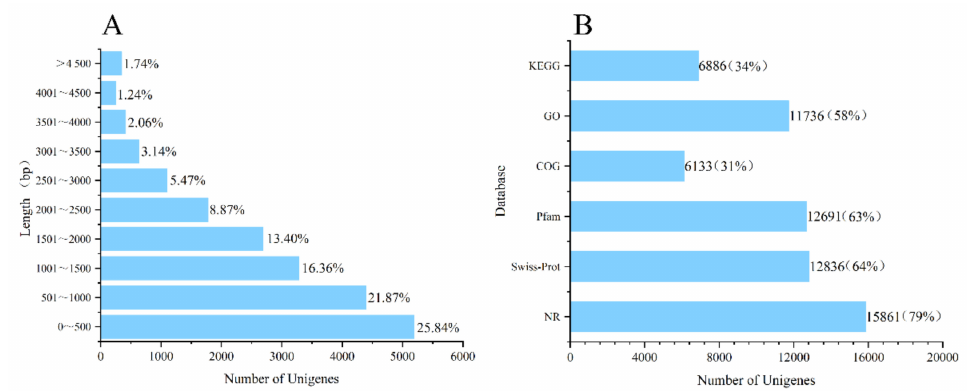
Figure 2. Length distribution ( A ) and annotation statistics ( B ) of unigenes. KEGG: Kyoto Ency- clopedia of Genes and Genomes; GO: Gene Ontology; COG: Clusters of Orthologous Groups; NR: NCBI